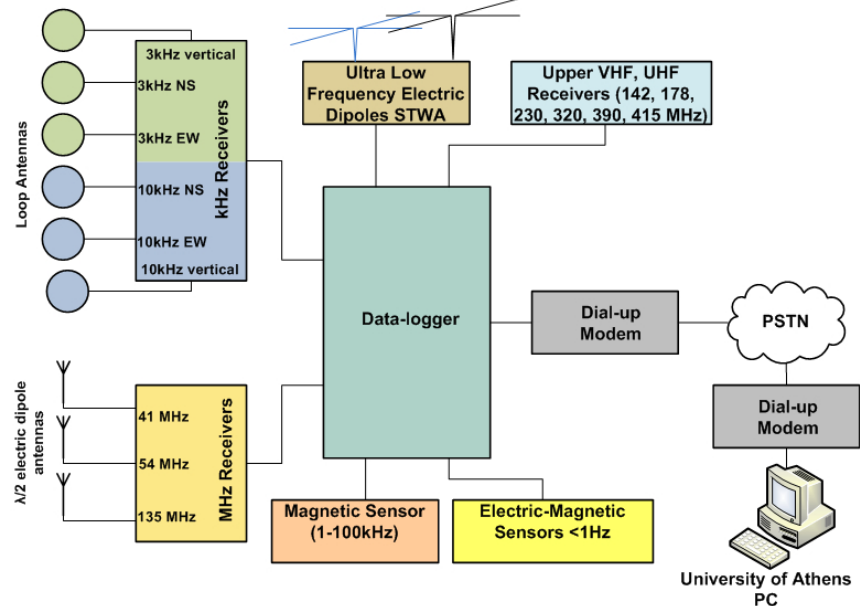
Fig. 1. The block diagram of the measurement configuration installed at the Zante remote telemetric station. The recorded data are acquired and regularly forwarded to the central telemetric station of the University of Athens through